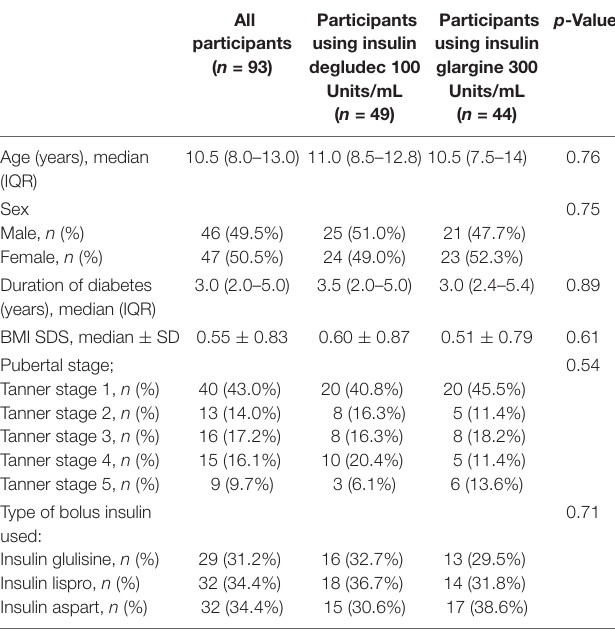
TABLE 1 | Baseline clinical characteristics of the study participants.